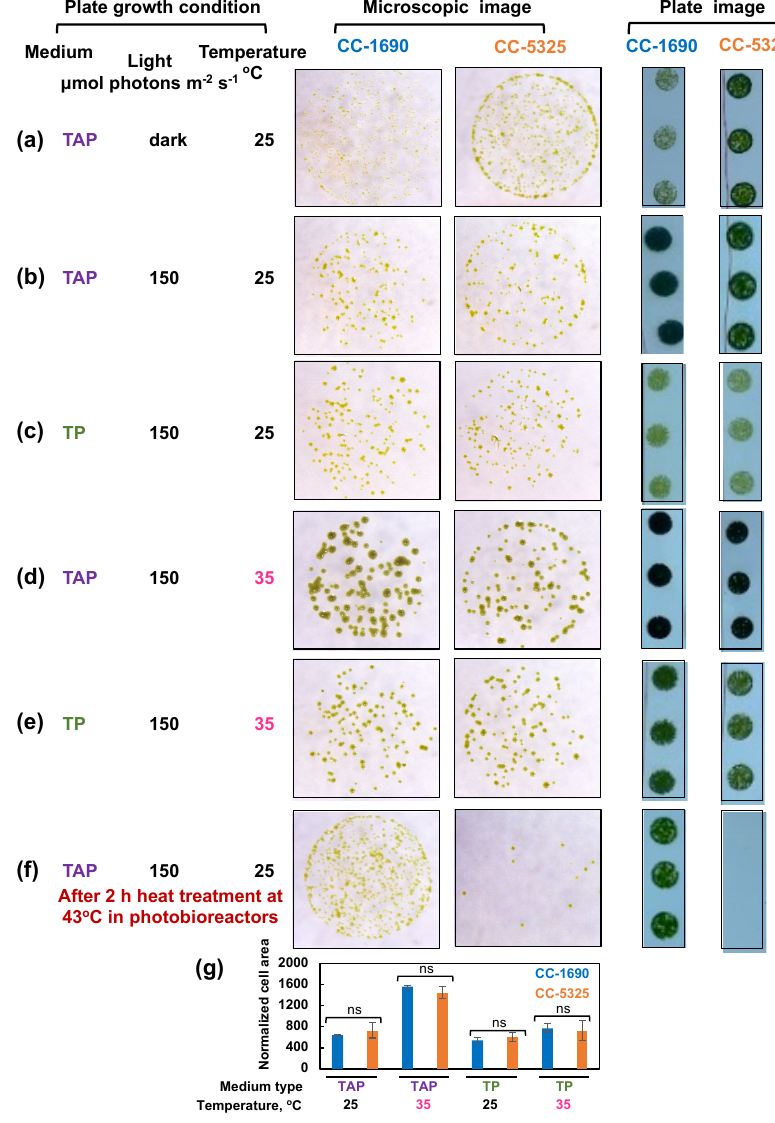
Figure 5. CC-5325 grew better in the dark with acetate but was more heat-sensitive than CC-1690. ( a – e ) Algal cells grown in PBRs at 25 °C under the same condition as in Figure 2 were harvested, diluted, and spotted on agar plates, and grown under the indicated growth conditions in temperature-controlled incubators. Cultures with the same cell density were used for each spot. ( f ) Algal cells were heat-treated at 43 °C for 2-h in PBRs before spotting; cultures with equal volume and the same dilution were used for each spot. TAP, Tris-acetate-phosphate medium with acetate. TP, Tris-phosphate medium without acetate. The same dilution and growth duration were used for the two strains under the same condition. ( a , f ) Algal cultures with 1:20 dilution, about 1000 cells in 10 µ L, were used for spotting. ( b – e ) Algal cultures with 1:100 dilution, about 200 cells in 10 µ L, were used for spotting. Single algal spots were imaged using a dissect microscope after 5-day ( a ) or 44-h ( b – f ) of growth. Plate images (all 1:20 dilution) were taken after 10-day ( a ) or 3-days ( b – f ) of growth using a regular camera. Images shown are representative of three biological replicates. ( g ) Normalized cell area. The 44-h spotting images were analyzed by ImageJ to get cell areas which were then normalized to the number of cells spotted. Statistical analyses were performed using a two-tailed t - test assuming unequal variance by comparing with CC-1690 under the same experimental conditions. Not significant, ns. Such quantification was not performed for ( a , f ) because the cell areas for one of the strains were too small to